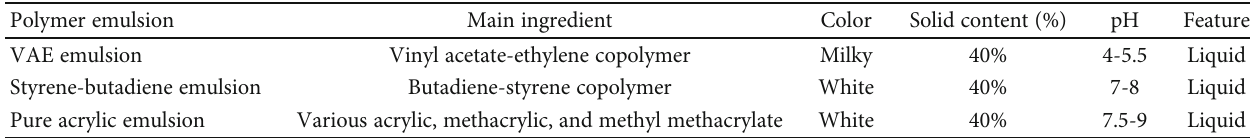
Table 4: Polymer emulsion composition characteristic